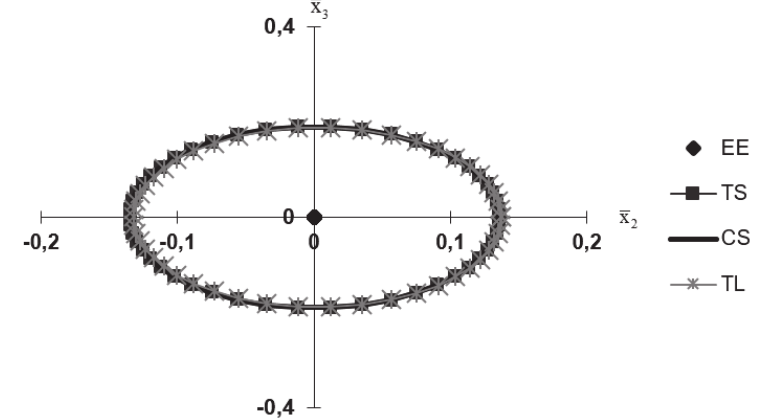
Figure 2: Evolution of the load surface in the deviatory plan 